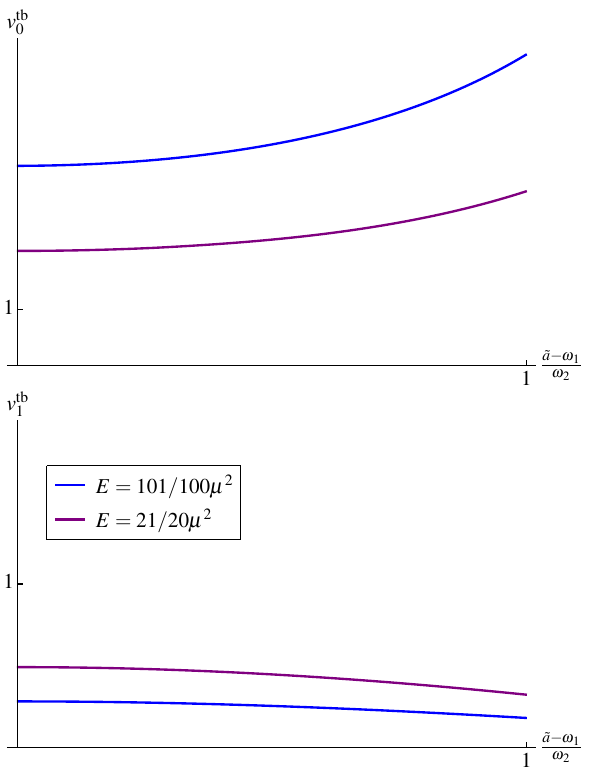
Fig. 9 The solution with D 2 < 0 at ξ 1 = 0 for two distinct Bäck- lund parameters. The seed solution has energy density E = 3 μ 2 / 2 and the Bäcklund parameter takes the value a = 1 . 45482 on the top, corresponding to a periodic solution with c = 1 / 2, and the value a = 1 . 36771 on the bottom, corresponding to a non-periodic solution √ with c = ( 5 − 1 )/